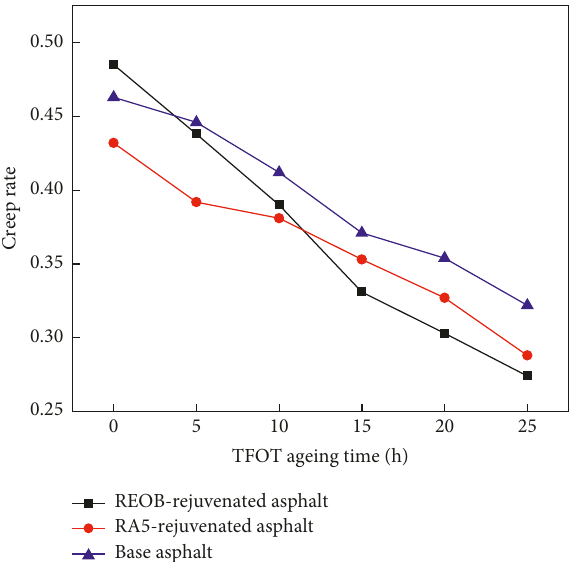
Figure 6: Relation between creep and TFOT ageing time.